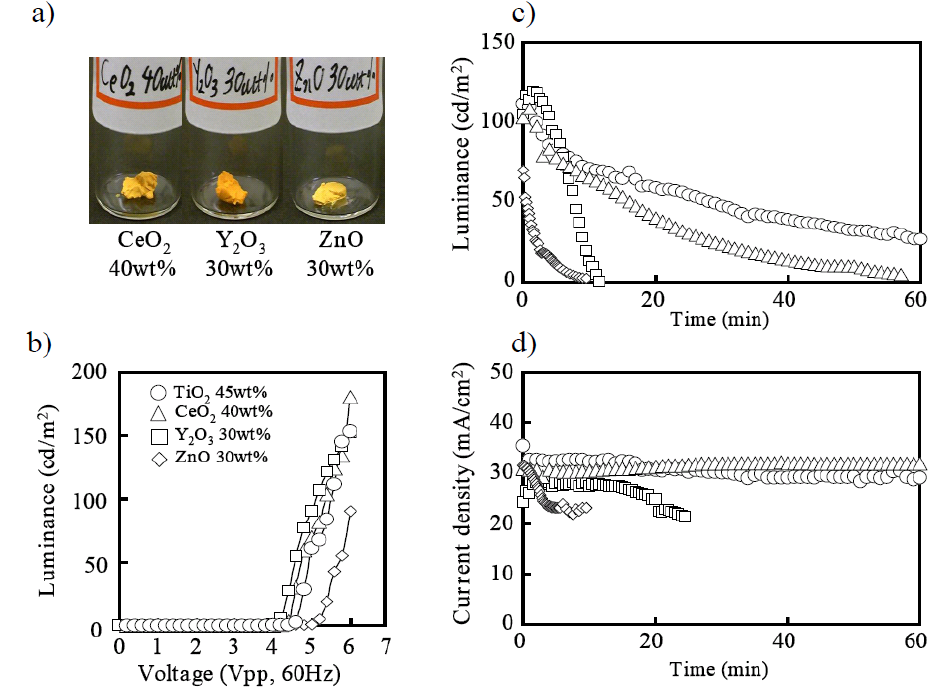
Figure 5. (a) Photographs of ECL gels solidified by CeO See text for explanation of figure. (b) Characteristics of luminance of the voltage applied to ECL gels. (c) Duration characteristic of luminance of ECL gels. (d) Time characteristic of current density of ECL